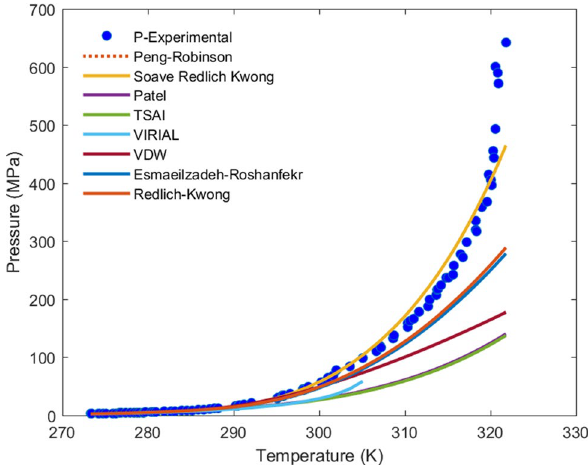
Fig. 6 Predicted pressure versus experimental plot for L H – V phase region, AAD %, [Min/Max] of w –